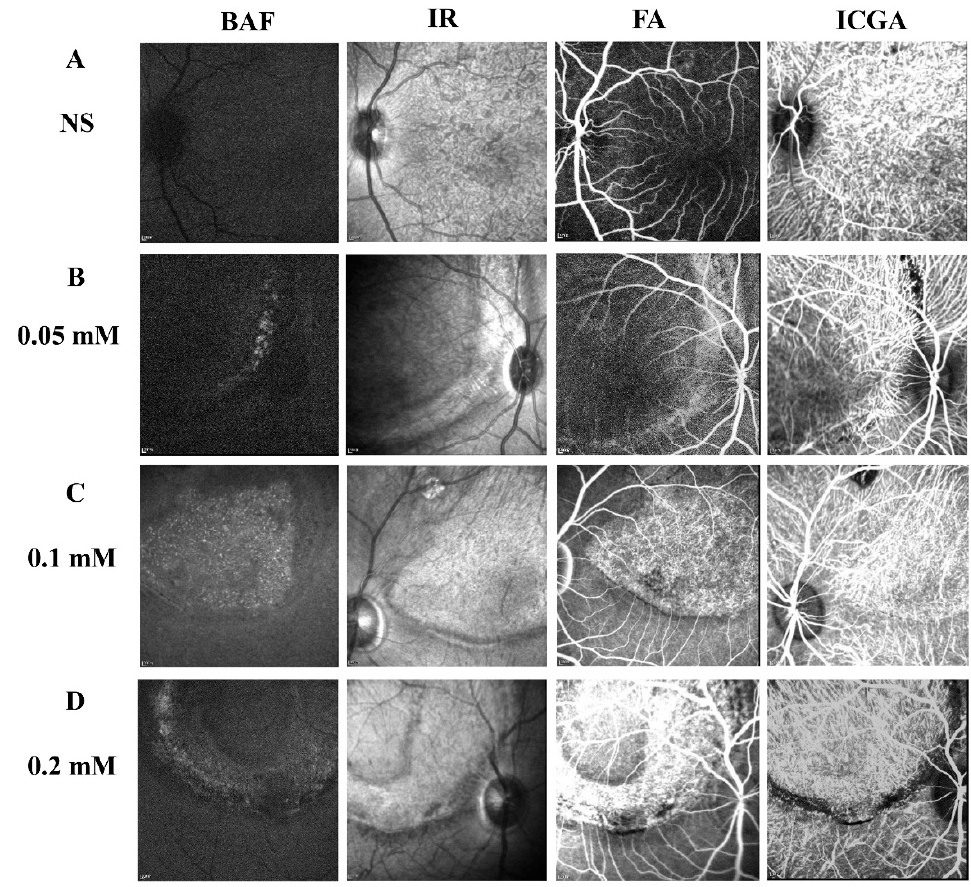
Figure 6. Multimodal images showing the stable and long-lasting retinal degeneration lesions in cynomolgus monkeys. ( A – D ) Multimodal imaging of BluePeak autofluorescence (BAF), infrared (IR), fluorescein angiography (FA), and indocyanine green angiography (ICGA) performed in the fifth month for the SNP groups of three doses and the NS control group. The fundus FA images were taken at the arteriovenous phase. The fundus images of ICGA were taken at the early phase.